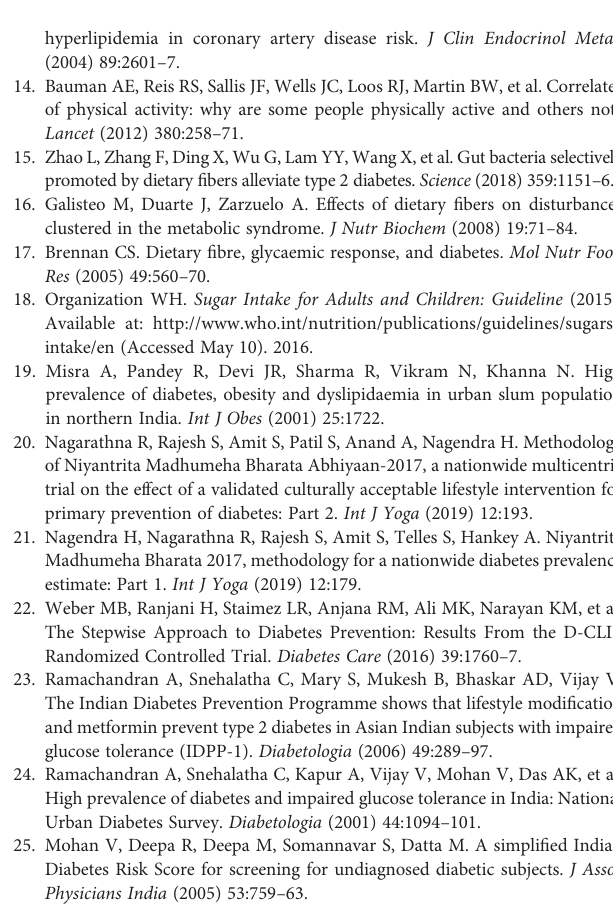
SUPPLEMENTARY TABLE 4 | for Physical activity